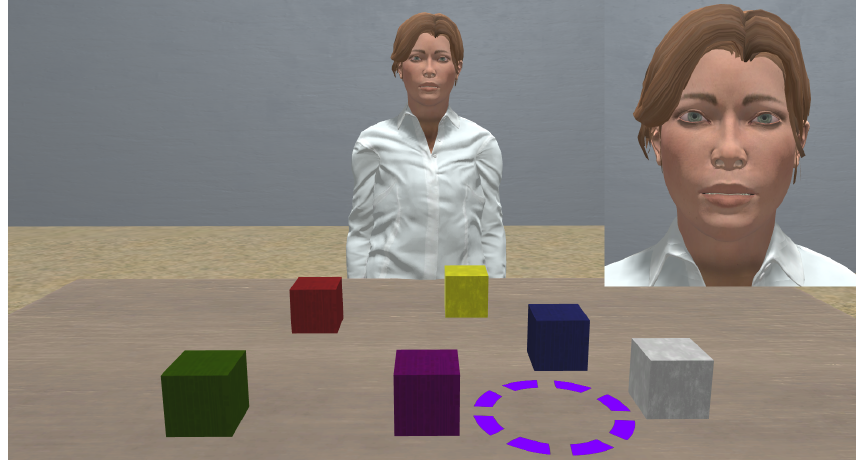
Figure 14. Confusion.